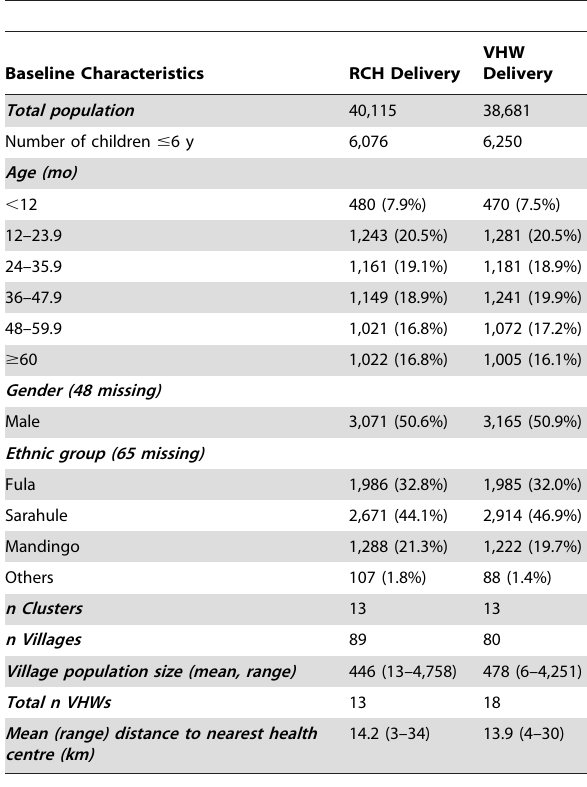
Table 1. Baseline characteristics of the children in the two study groups.